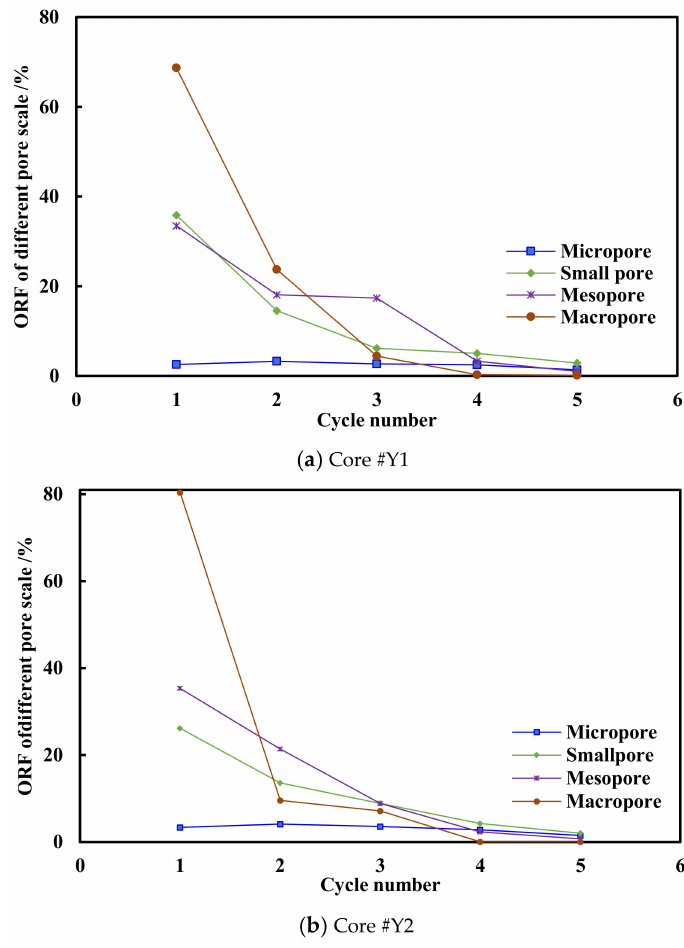
Figure 14. ORF of different pore scales versus cycle